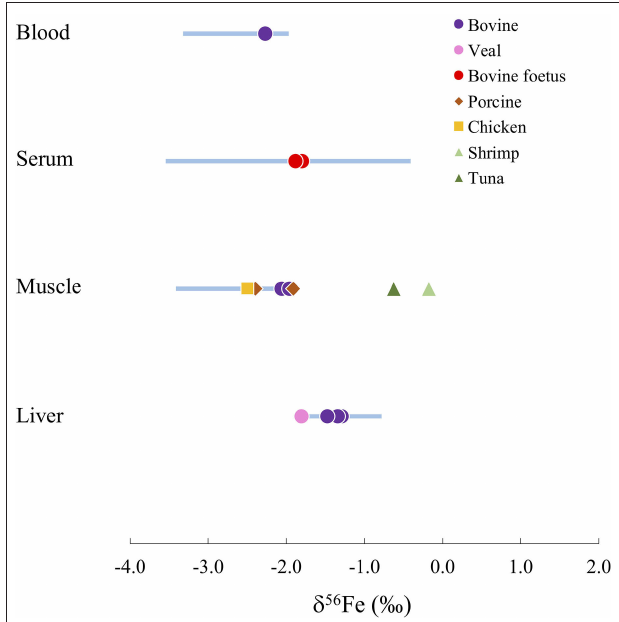
FIGURE 4 | Comparison of the Fe isotope composition δ 56 Fe in different human organs (blue bars) and other animal species